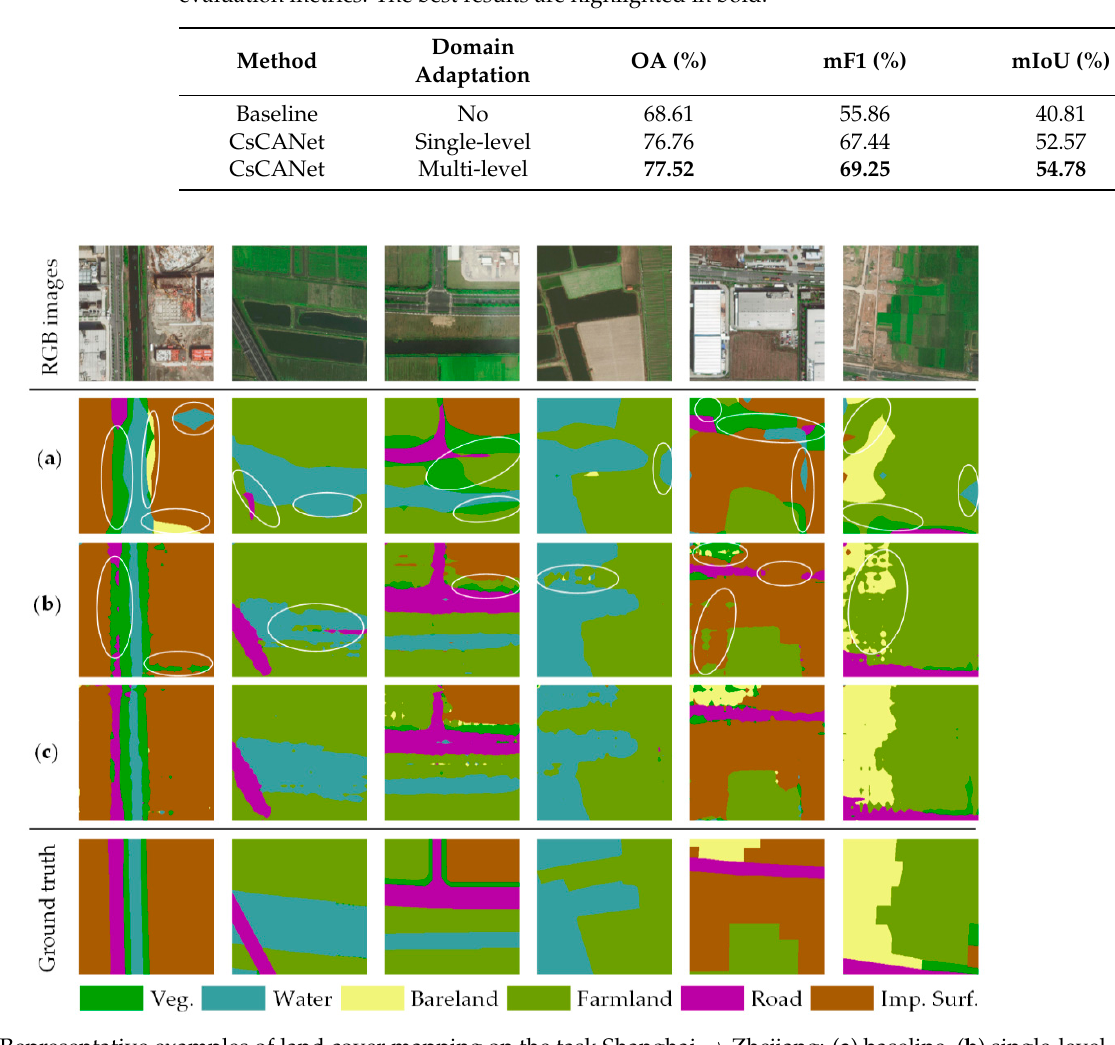
Figure 8. Representative examples of land cover mapping on the task Shanghai → Zhejiang: ( a ) baseline, ( b ) single-level CsCANet, ( c ) multi-level CsCANet. RGB images and the corresponding ground truth are presented in unison. We circle the negative results in white